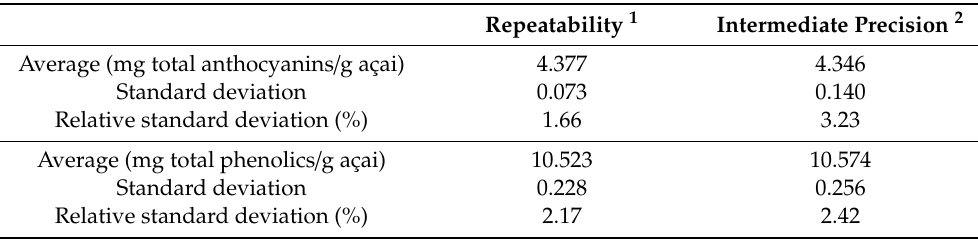
Table 3. The results obtained from the repeatability and intermediate precision study for anthocyanins and total phenolic